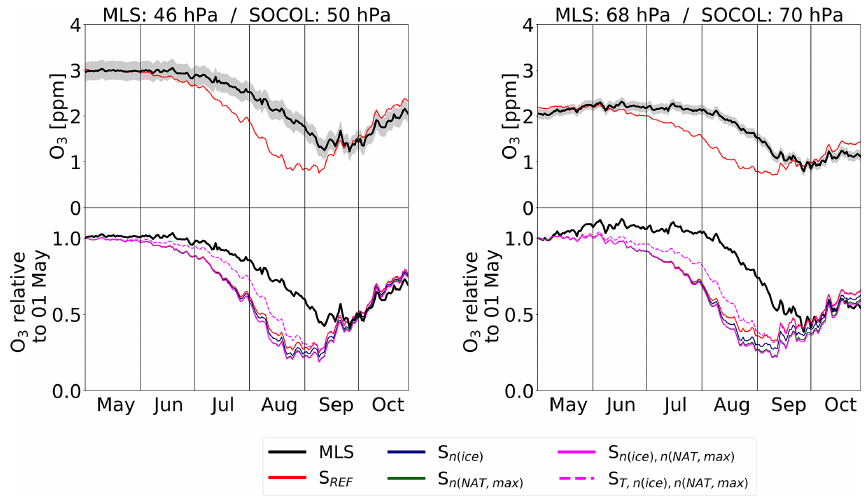
Figure 9. Same as Fig. 7, but for O 3